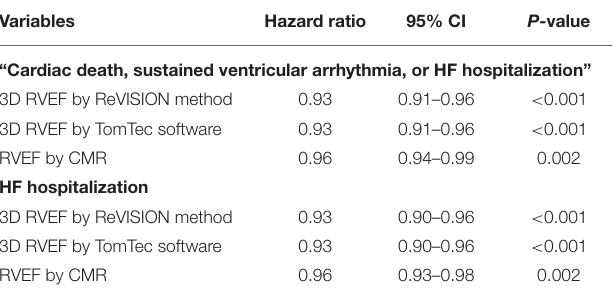
TABLE 5 | Comparison of the prognostic value of RVEF among ReVISION method and the other methods. Variables